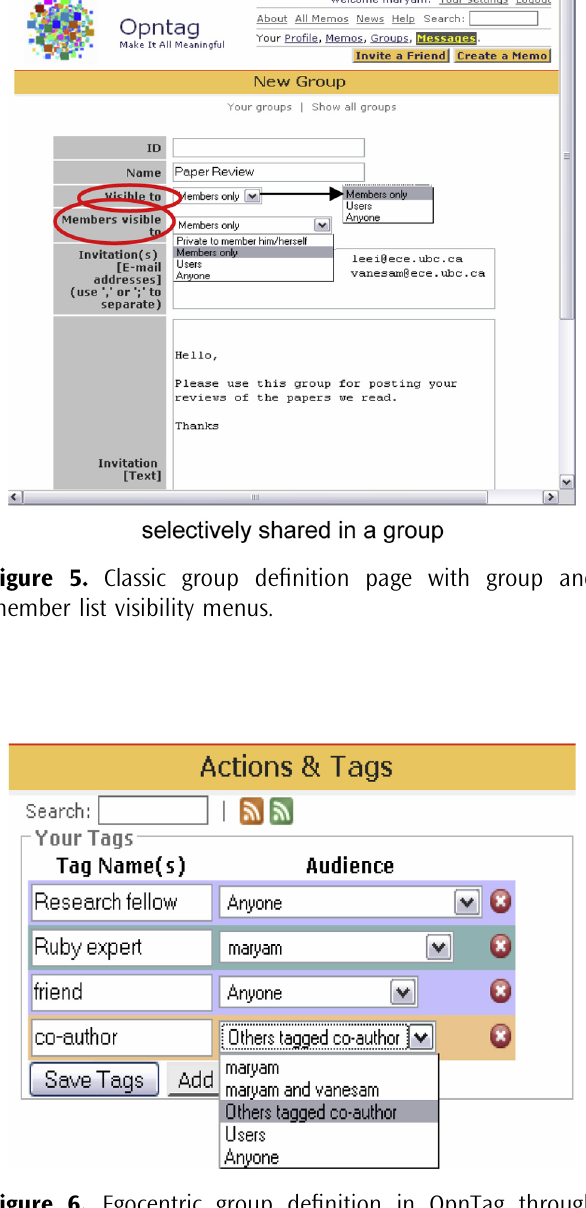
Figure 6. Egocentric group definition in OpnTag through applying tags to users.